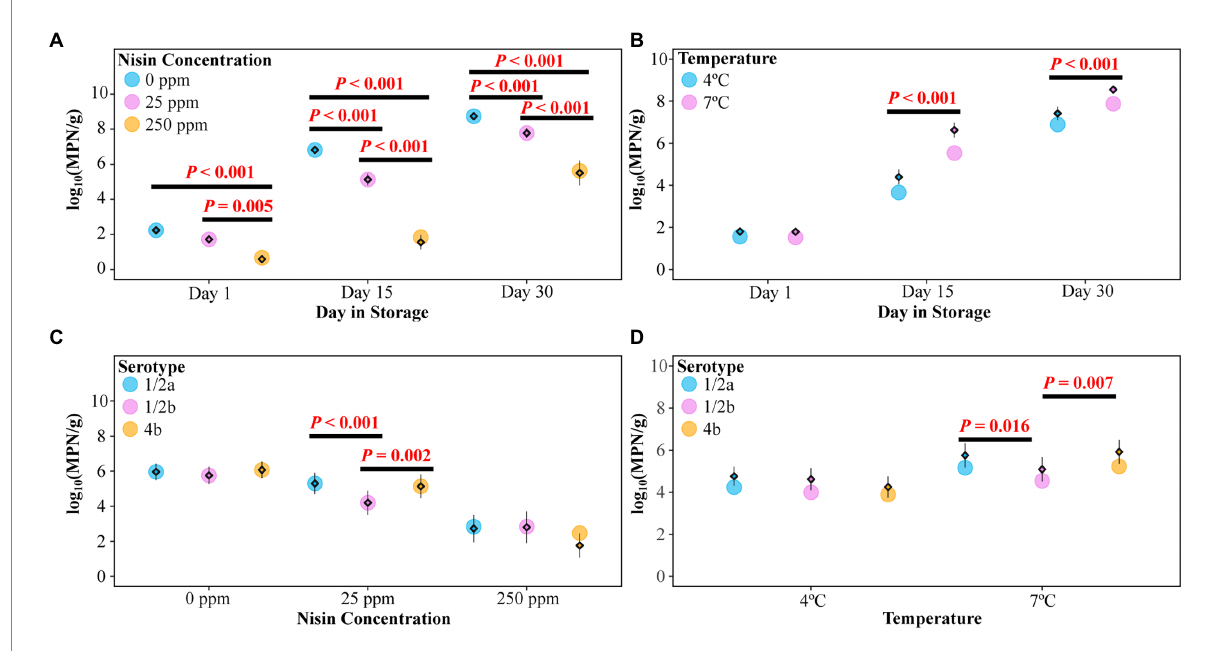
FIGURE 3 Listeria monocytogenes levels [in log 10 (MPN/g)] on cold-smoked salmon treated with different nisin concentrations and tested on days 1, 15, and 30. Within each panel, raw data points are summarized as means (standalone diamonds) ± standard errors (shown as error bars, which sometimes are not visible due to their small values, e.g., the day 1 data shown in panel A) and estimated marginal means of the L. monocytogenes level (EMMLM) obtained from the mixed effects linear model (the Level Model) were plotted as circles. (A) EMMLMs (averaged over serotypes and storage temperatures) compared across different nisin concentrations on each day in storage. (B) EMMLMs (averaged over nisin concentrations and serotypes) compared between storage temperatures on each day in storage. (C) EMMLMs (averaged over storage temperatures and days in storage) compared across different serotypes for each nisin concentration. (D) EMMLMs (averaged over nisin concentrations and days in storage) compared across different serotypes for each storage temperature. Pairwise comparison of the EMMLMs (within each category shown on the X axis of each panel) was performed using the Tukey’s HSD test (overall α = 0.05). Significant differences were indicated by the p values above horizontal